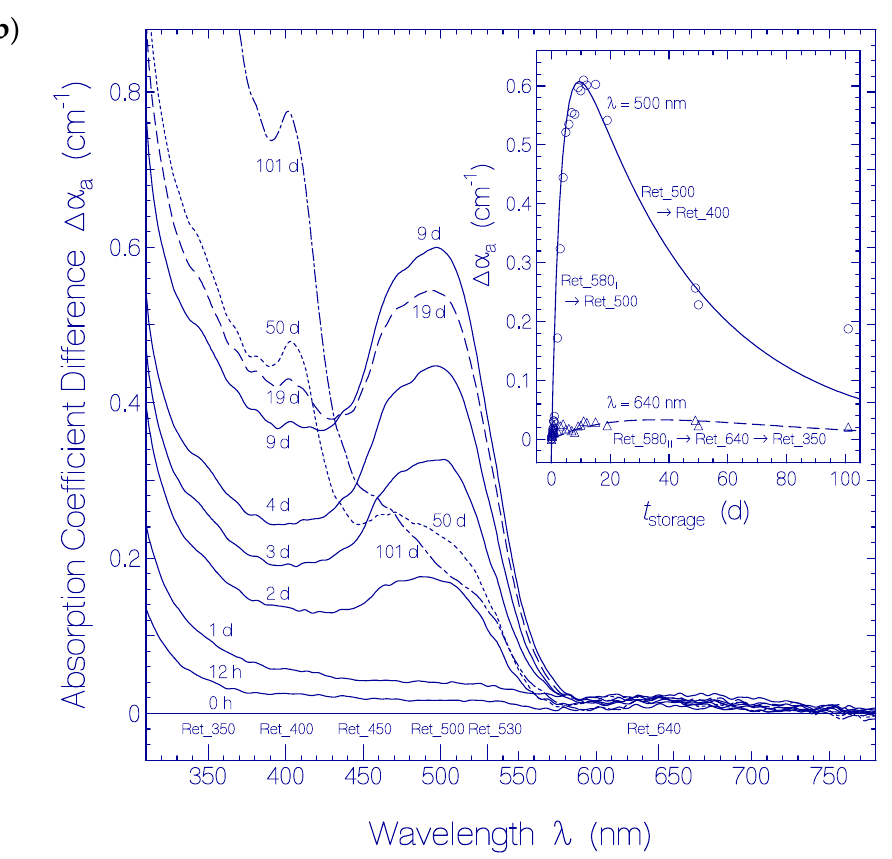
Figure 7. ( a ) Temporal development of absorption coe ffi cient spectra α a ( λ ) of QuasAr1 in pH 8 Tris bu ff er stored in the dark at room temperature ( ϑ = 21–25 ◦ C). The storage times are listed in the legend ( t storage = 0 h refers to absorption coe ffi cient spectrum measurement immediately after sample thawing). The inset shows the temporal development of α a (580 nm) where the circles are data points and the solid curve is a two-component single exponential fit according to (cid:104) (cid:105) α α κ ( − t storage / τ ) + κ ( − t storage / τ ) a ,580 nm ( t storage ) = a ,580 nm ( 0 ) Ret_580 I exp Ret_580,I Ret_580 II exp Ret_580,II = 0.41, τ = 3.8 d, κ = 0.59, and τ = with α a,580 nm (0) = 2.193 cm − 1 , κ Ret_580 Ret_580 I Ret_580 II Ret_580 II I 120 d. ( b ) Temporal development of the corresponding di ff erence absorption coe ffi cient spectra ∆ α λ , t α λ , t − α ( λ , t storage ) − α ( λ ,0 ) . The inset shows ∆ α a a ( storage ) = a ( storage ) a ,Ret_580 a ,residual retinals at λ = 500 nm and λ = 640 nm versus storage time t storage . The ∆ α a data at λ = 500 nm are fitted by